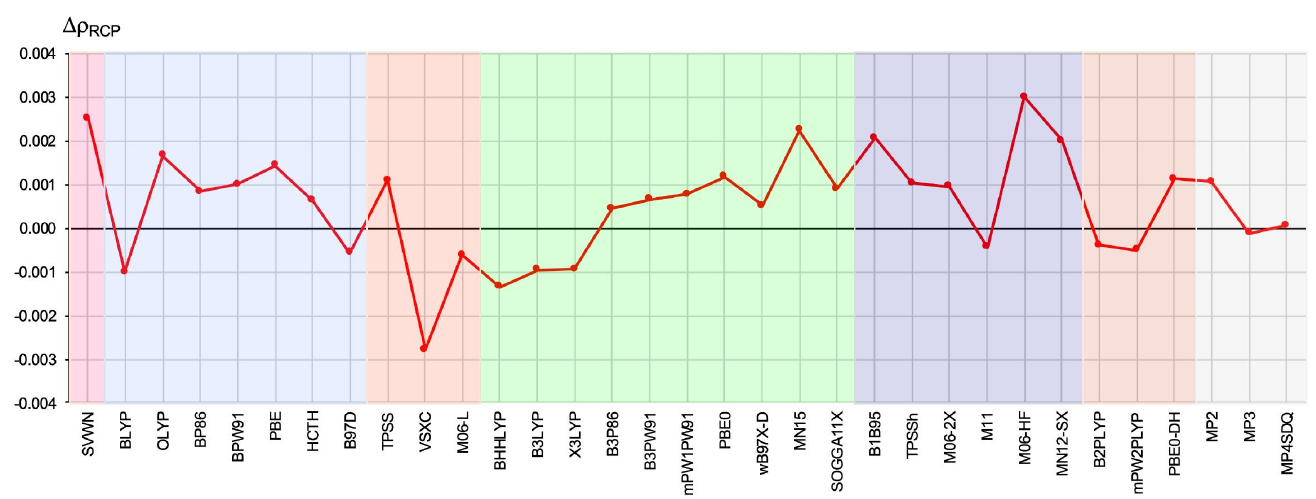
Figure 5. The difference (in relation to the CCSD method) in the value (in a.u.) of the elec- tron density determined at the ring critical point of the 2,2-dichloro-1-(1H-pyrrol-2-yl)ethan-1-one molecule. The different types of methods are represented by a colored background: LDA—pink, GGA—blue, M-GGA—orangeish, H-GGA—green, HM-GGA—violet, DH-GGA—beige, perturbational methods—gray.